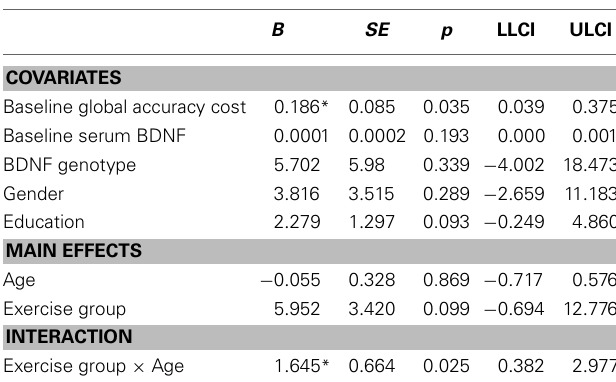
Table 4 | Age moderates effect of exercise group on global task switch accuracy